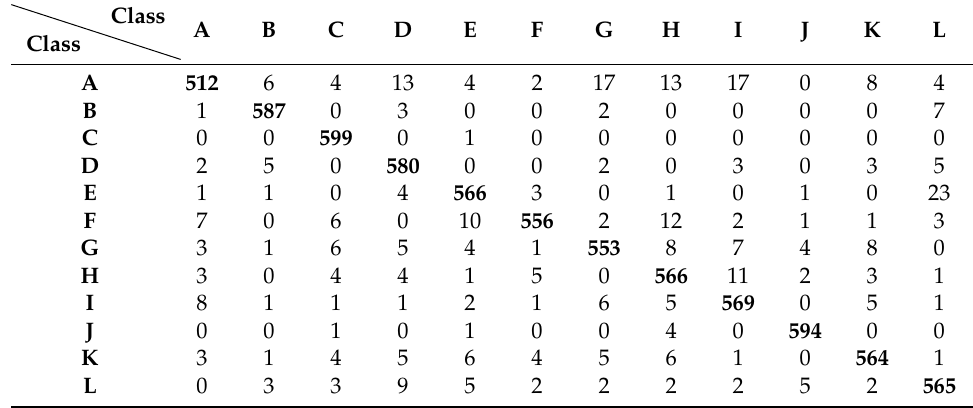
Table 9. Classification result after combination using Max rule.